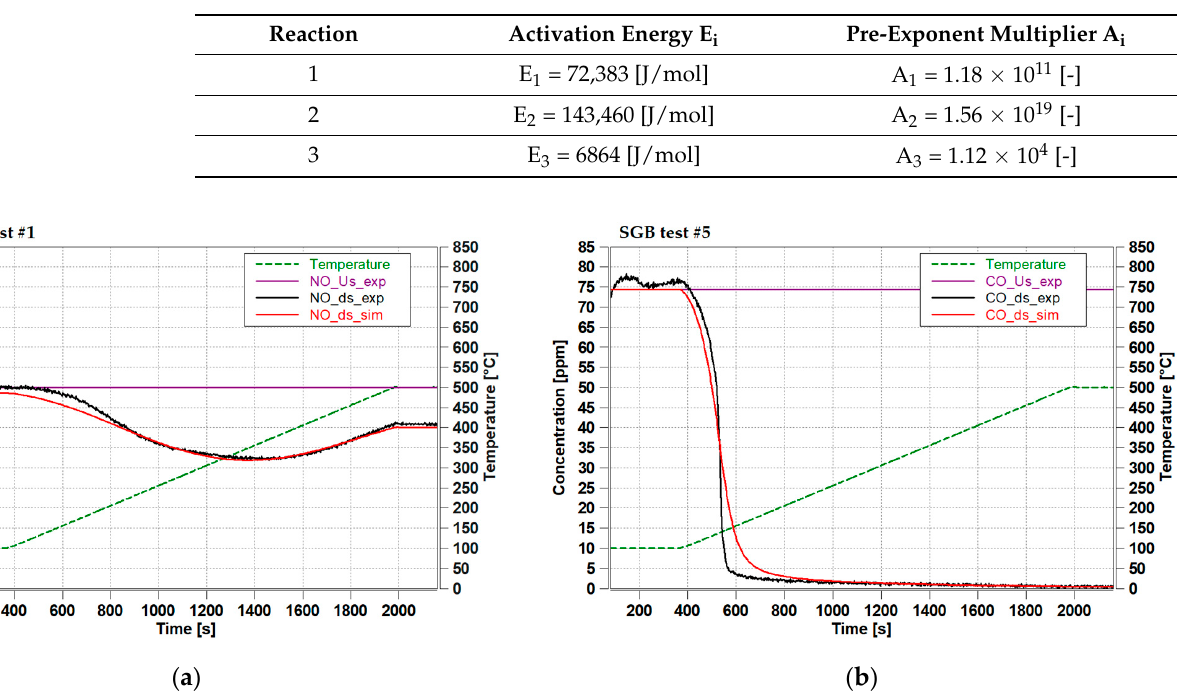
Table 9. DOC kinetic model: values of reactions activation energies and pre-exponent multipliers.